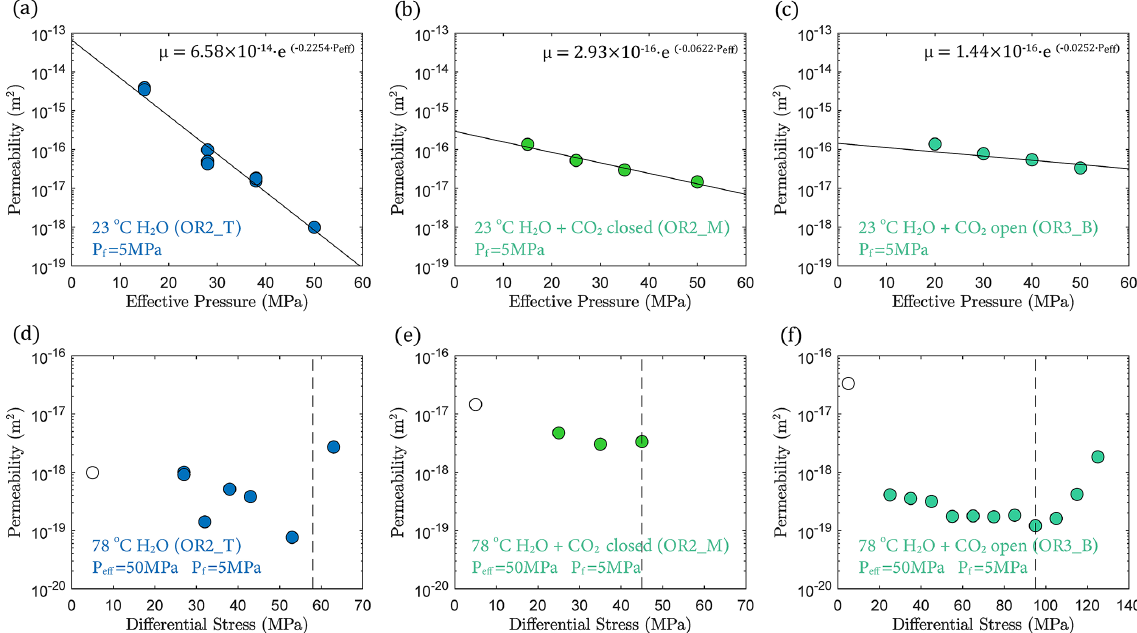
Figure 6. Permeability evolution due to changes in effective pressure (a, b, c) and differential stress (d, e, f) . The dashed line marks the onset of transition from compaction to dilatancy ( C ∗(cid:48) ) as previously shown in Fig. 4. The empty circle indicates the permeability measurement before